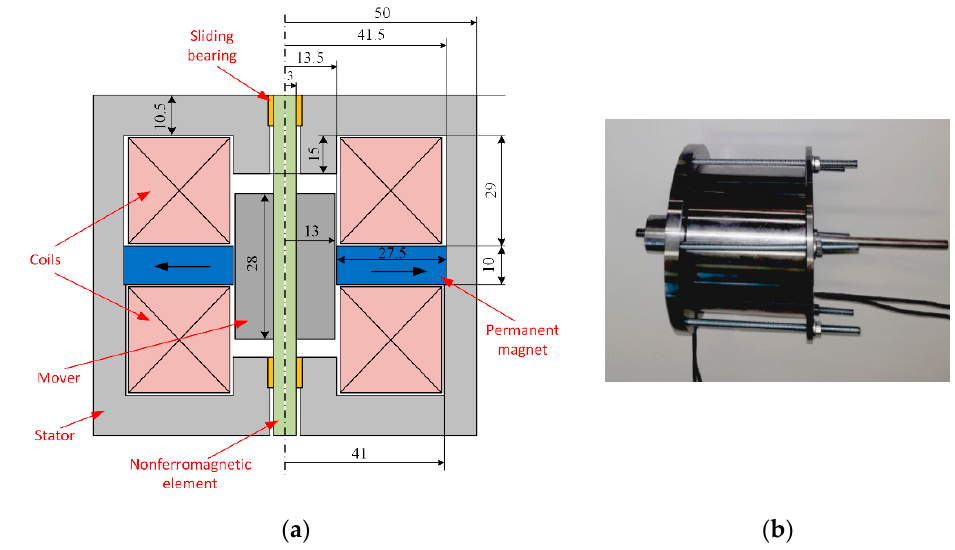
Figure 1. ( a ) Main dimensions of the actuator and ( b ) picture of the prototype.